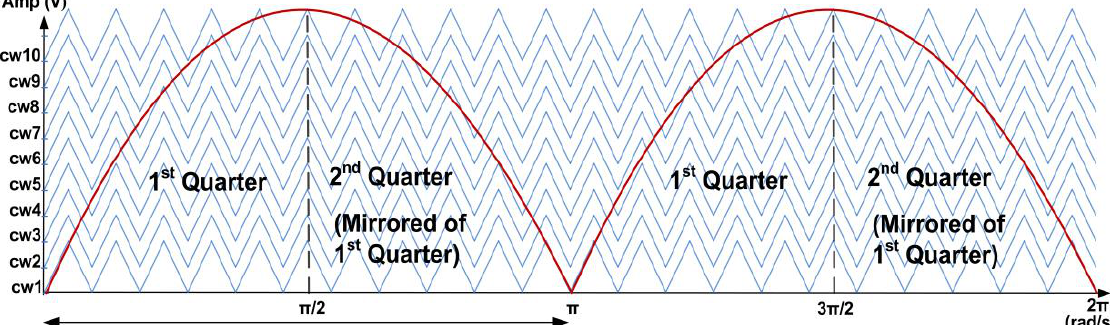
Figure 9. Ten symmetric dispositions of multicarrier phase-disposition PWM (PD-PWM) for a sinusoidal reference signal with a positive cycle only.